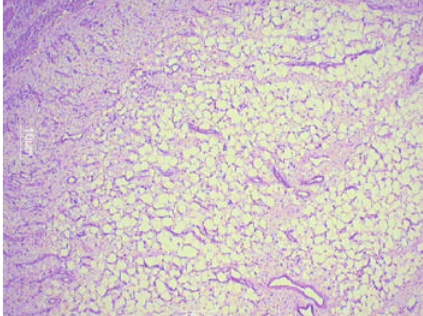
Figure 1: CECT showing typical target sign.